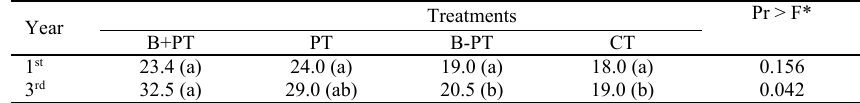
Table 1: The effects of three years treatments on soil organic carbon (g/kg)